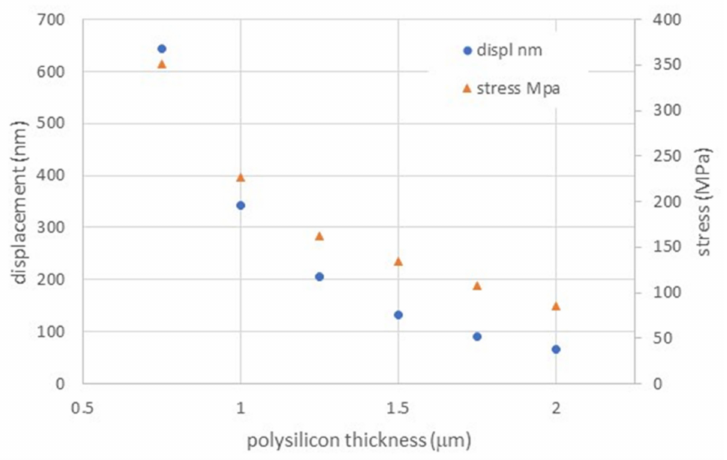
Figure 4. Maximum displacement at membrane center as a function of polysilicon thickness, with membrane side of 100 µ m and a silicon nitride thickness of 200